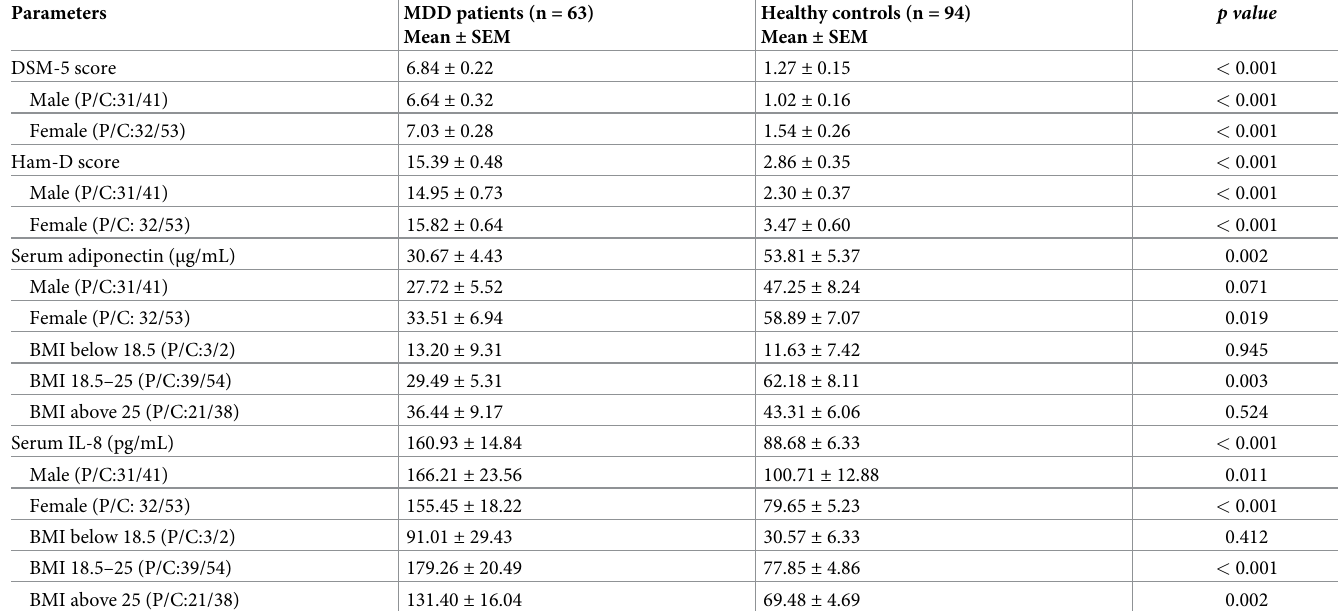
Table 2. Clinical profile and laboratory findings of the study population.